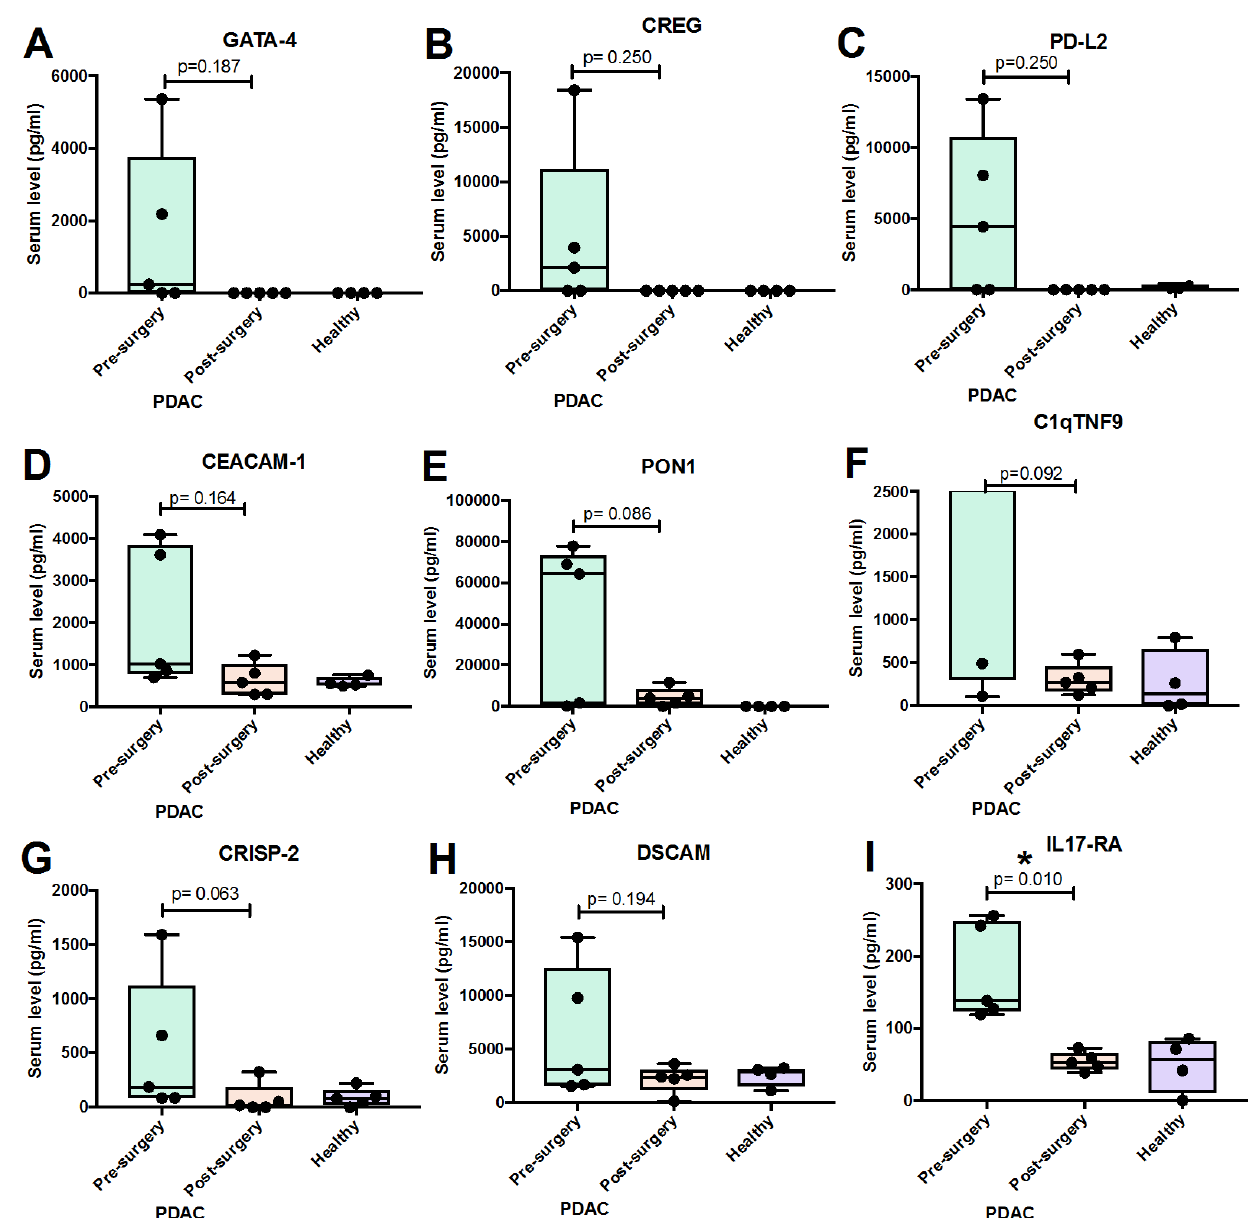
Figure 4. Group analysis of proteins that showed decrease in serum level in individual pancreatic cancer (PDAC) patients collected before and after surgery. Wilcoxon or paired T-test was used to collectively compare paired patient samples obtained pre-surgery (n=5) and post-surgery (n=5). The healthy group consists of all aliquots from the controls (n=4). Only IL-17RA levels were significantly reduced post-surgery (P<0.01, paired